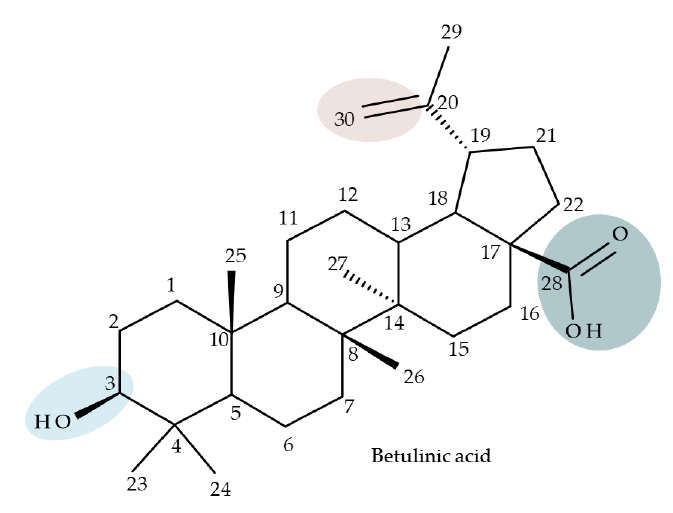
Figure 3. Frequent targets for the derivatization of betulinic acid.